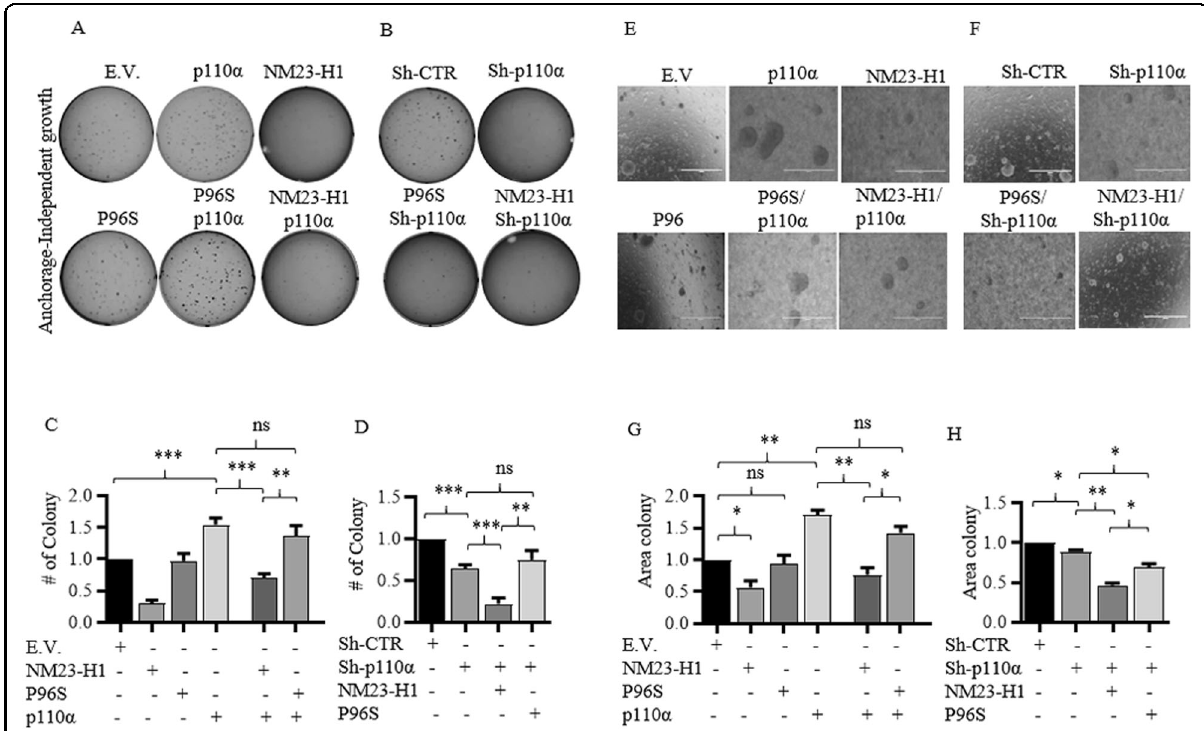
Fig. 7 Expression of NM23-H1 with p110 α impairs the clonogenicity and anchorage-independent growth of MDA-MB-435 cells. A , B MDA- MB-435 clones were tested for anchorage-independent growth in soft agar assays. Cells were seeded at low density (1 × 10³). After 14 days cells were stained with 0.05% Crystal Violet O.N. The number ( C , D ) and size of colony ( E – H ) were counted and represented by a bar graph ( G , H ). T -test statistical analysis was performed. n = 3. (* p < 0.05; ** p < 0.01; *** p < 0.001; ns not statistically signi fi